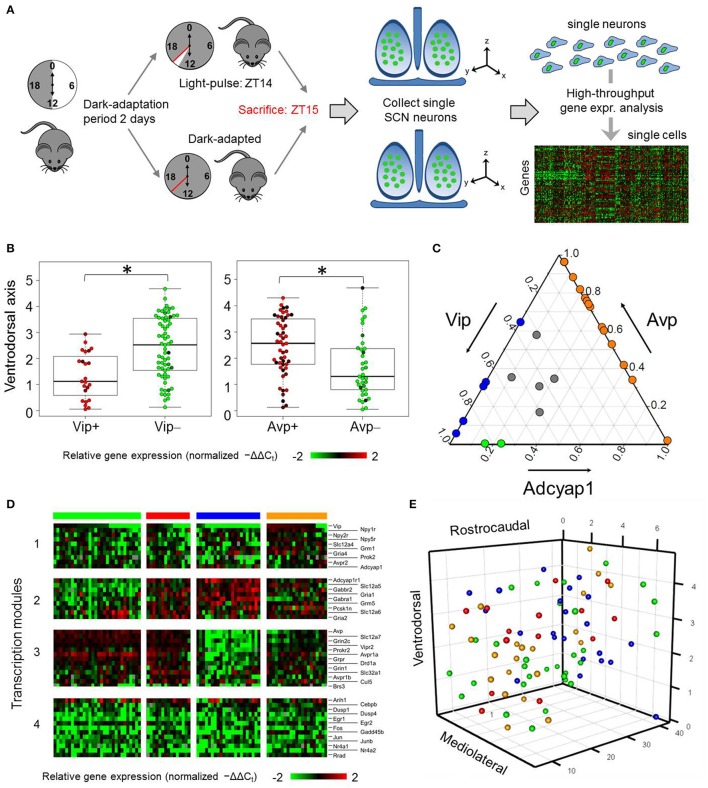
Single-cell analysis of SCN neurons from dark-adapted mice reveals multiple states. (A) Process flow diagram of experimental approach taken to obtain single-neuron samples and transcriptomic measures from mice that adapted to a dark-dark (DD) cycle or light pulse (LP) treatment. (B) Ventrodorsal positioning of individual Vip+ (−ΔΔCt > 0) and Vip- (−ΔΔCt ≤ 0) neurons. A Wilcoxon rank sum test was performed to determine if there were significant differences in ventrodorsal positioning between the two neuron groups. A p-value of 1.78 × 10−4 indicates that the null hypothesis can be rejected and that there is a statistically significant difference between the ventrodorsal positioning of Vip+ and Vip- neurons. Similarly, significant differences in ventrodorsal positioning were observed between Avp+ and Avp- neurons (Wilcoxon rank sum test p-value = 1.14 × 10−3). *indicates statistically significant differences (p < 0.05). (C) Ternary plot of the proportional expression levels of the neuropeptide genes Vip, Avp, and Adcyap1, which sum to a total value of 1. Each circle represents an individual neuron's compositional Vip-Avp-Adcyap1 expression profile. These samples form a subset of single neurons from dark-adapted mice that have positive normalized expression of the three genes of interest. Colored circles represent individual neurons with positive coexpression of Vip/Avp (blue), Vip/Adcyap1 (green), Avp/Adcyap1 (orange), and Vip/Avp/Adcyap1 (gray). (D) Heat map visualizes relative expression levels (−ΔΔCt) of 32 key neuropeptide, receptor, and light-response genes measured in the 88 single neurons from DD mice. Hierarchical clustering, based on the Pearson correlation coefficient, revealed four groups of genes (transcription modules) showing correlated expression across four neuronal subpopulations (groups of columns) defined by gene expression profiles. Colored bars above each group correspond to specific subpopulations. (E) Mapping of SCN neuronal subpopulations. Color annotation of subpopulations identical to gene expression-based groups defined in (D). Single neurons were plotted based on their recorded spatial coordinates (Material and Methods) along the mediolateral, ventrodorsal, rostrocaudal axes of the SCN.